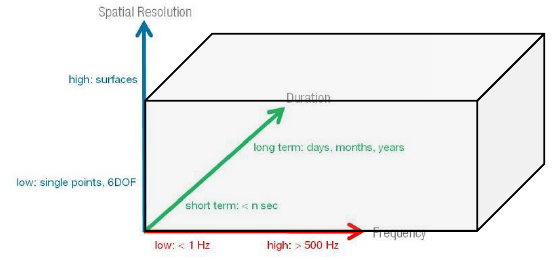
Figure 3: Frequency versus spatial resolution